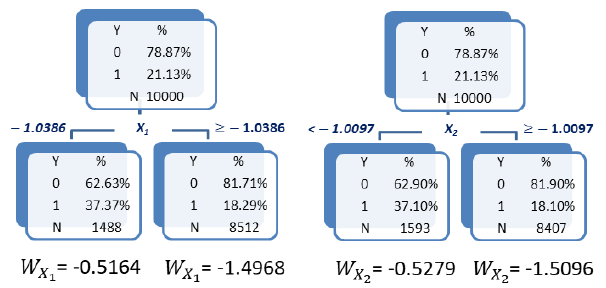
Figure 2. Univariate trees fitted using variables X 1 and X 2 .